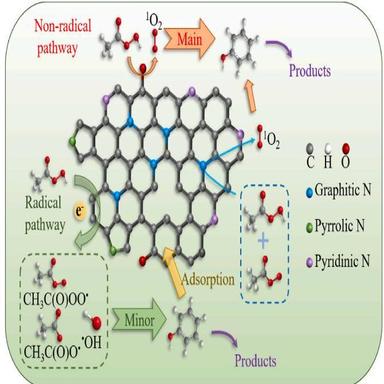
Proposed reaction mechanisms for phenol degradation in CPANI/ PAA system.